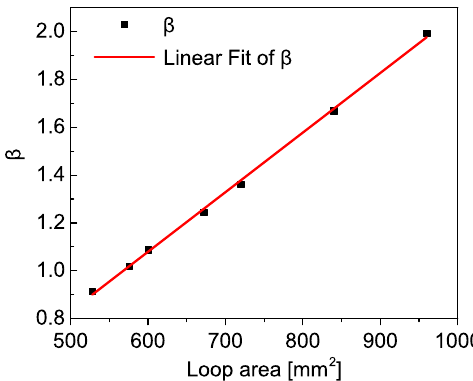
FIG. 32. The relationship between the coupling factor and the loop